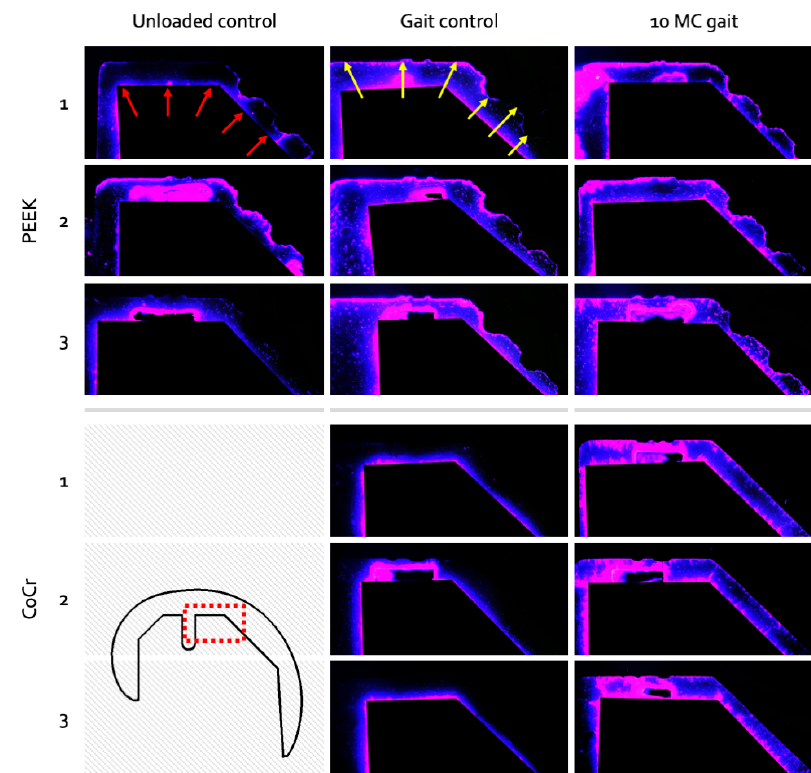
Figure 4. Test specimens under UV lighting show dye fluorescence intensity as blue-to-pink coloration with the pink area highlighting the highest dye uptake. Both cement–Delrin (red arrows) and implant–cement (yellow arrows) interfaces are visible. A section of the anterodistal cement mantle is shown at the three time intervals to demonstrate the appearance of dye penetration in both the PEEK and CoCr group. The variability within the PEEK soaked control group is noticeable, ranging from near-full bonding (Specimen 3) to complete debonding (Specimen 2). A clear evolution of dye penetrance in the CoCr can be seen, where no implant–cement interface is visible in the loaded controls, but full interface fluorescent is visible in the Group 3